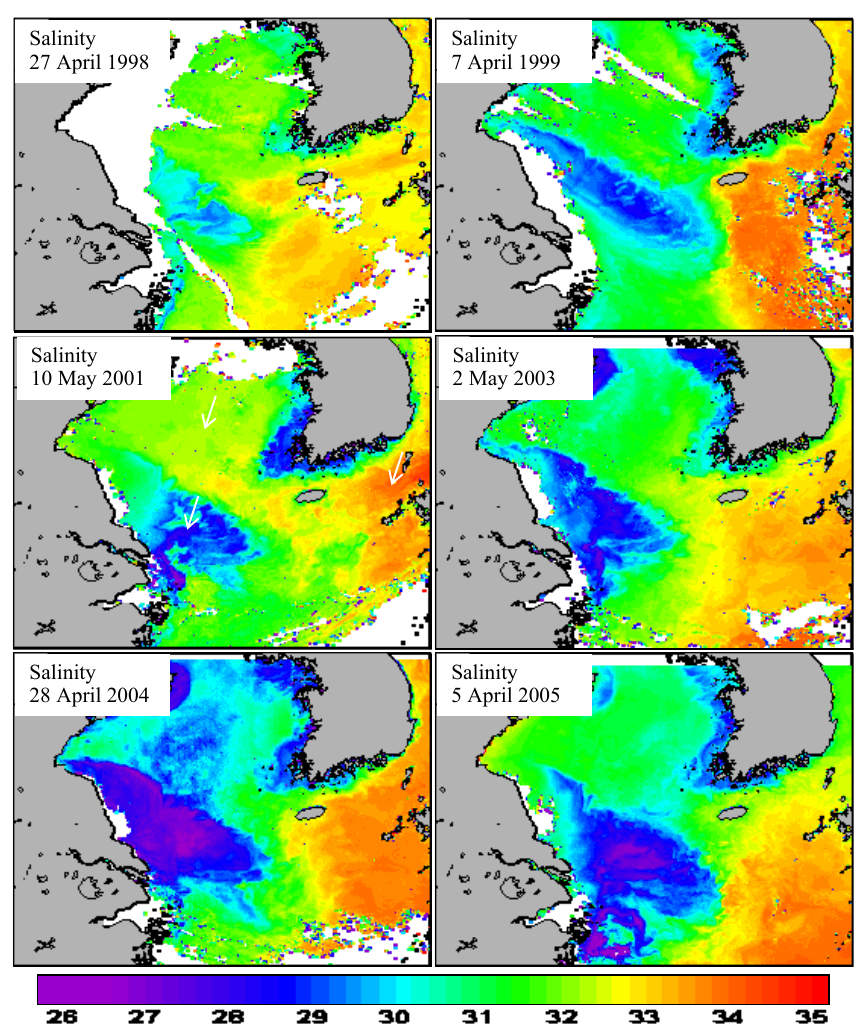
Fig. 8. Maps derived from the SeaWiFS images showing the springtime evolution of salinity fields (psu) in the ECS, YS and KSS. SSMM atmospheric correction was applied to process these images.